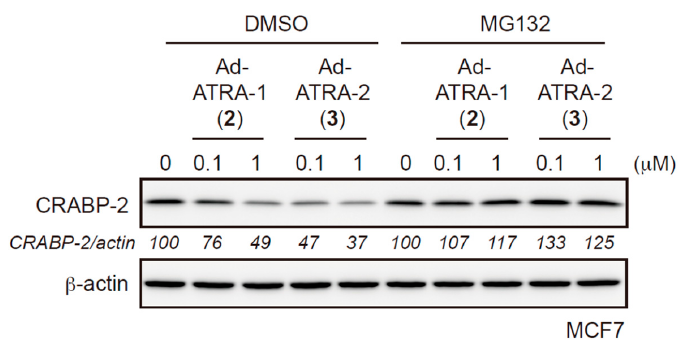
Figure 4. Proteasomal inhibitor MG132 inhibits the reduction of CRABP-2 by HyT compounds. MCF-7 cells were incubated with the indicated concentrations of HyT compounds in the presence or absence of 10 µM MG132 for 18 h. Whole-cell lysates were analyzed by western blotting.